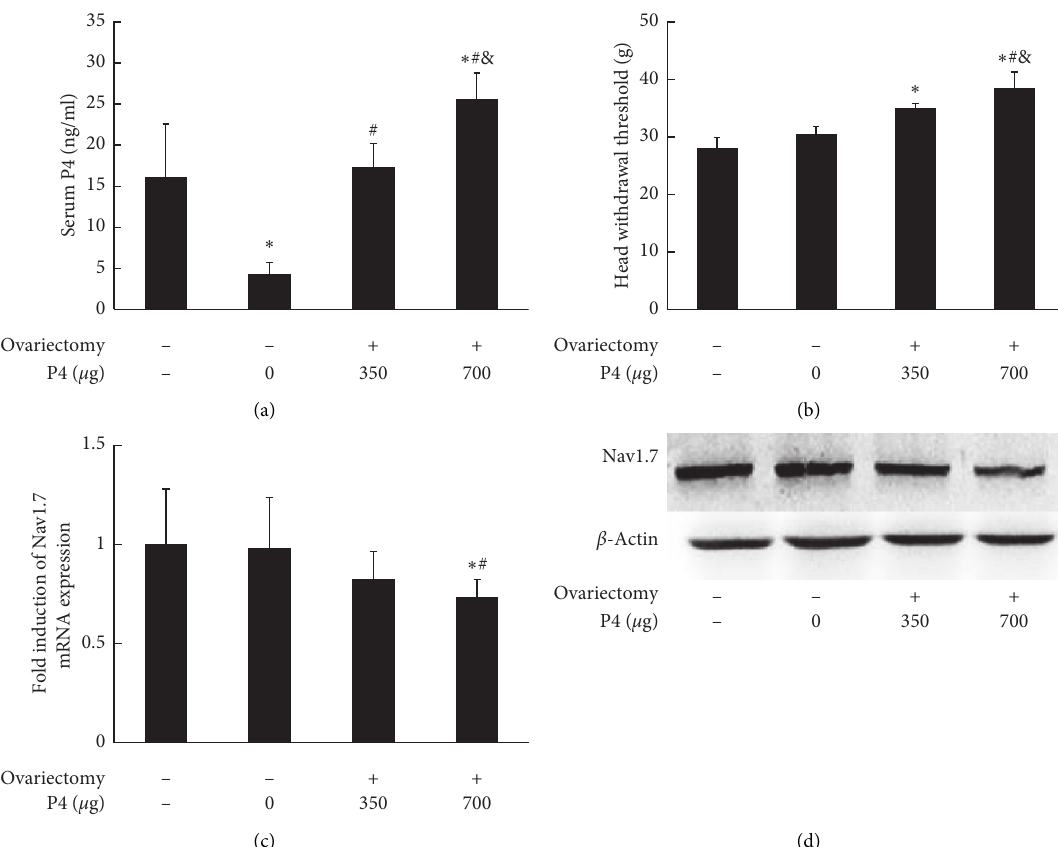
Figure 1: Progesterone dose dependently attenuated sensitivity of TMJ nociception and downregulated Nav1.7 expression in TG. (a) Confirmation of the effectiveness of ovariectomized and P4 replacement in rats. Serum levels of P4 in the ovariectomized groups treated with 0 μ g, 350 μ g, or 700 μ g P4 increased dose dependently. (b) Head withdrawal threshold. The lower the head withdrawal thresholds, the more sensitive the TMJ nociception will be. The head withdrawal threshold was increased by P4 application, suggesting that the sensitivity of TMJ nociception was decreased. (c) Real-time PCR analysis for Nav1.7 expression in TG. P4 increased the mRNA expression of Nav1.7 in TG. (d) Representative immunoblotting for Nav1.7 expression in TG after estrogen replacement. β -Actin served as an internal control for equal loading. ∗ P < 0 . 05 versus the control group; # P < 0 . 05 versus the 0 μ g group; & P < 0 . 05 versus the 350 μ g P4 group. Data are expressed as mean ±